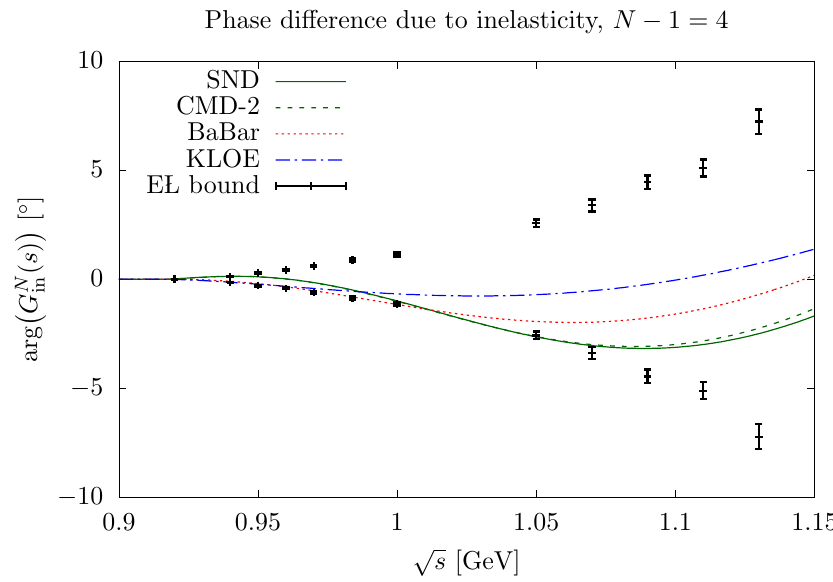
Figure 7. Phase of the inelastic contribution G N with the E L bound ( (cid:19) 1 = 0 :